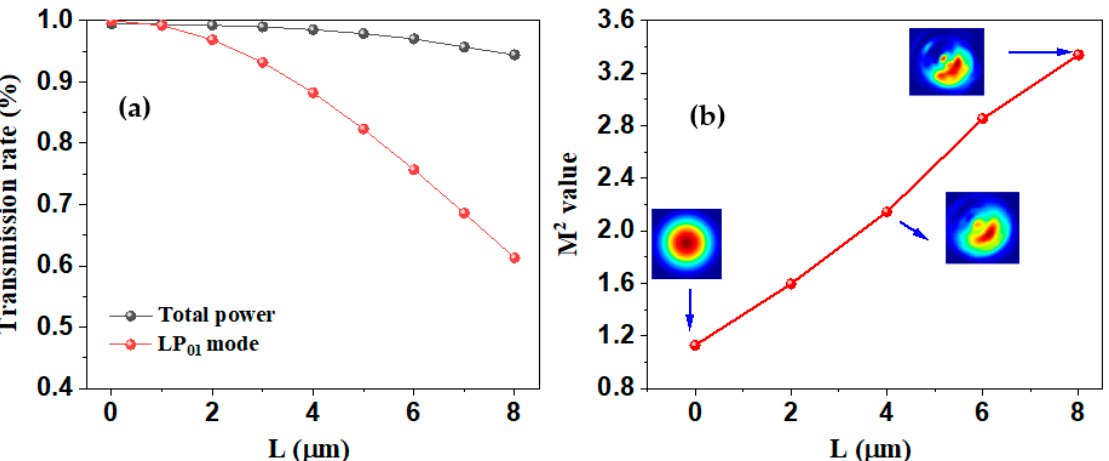
Figure 2. Theoretical relationships between the core off-axis value with the signal transmission rate ( a ) and the M 2 value ( b ). ( a ) and the M 2 value ( b